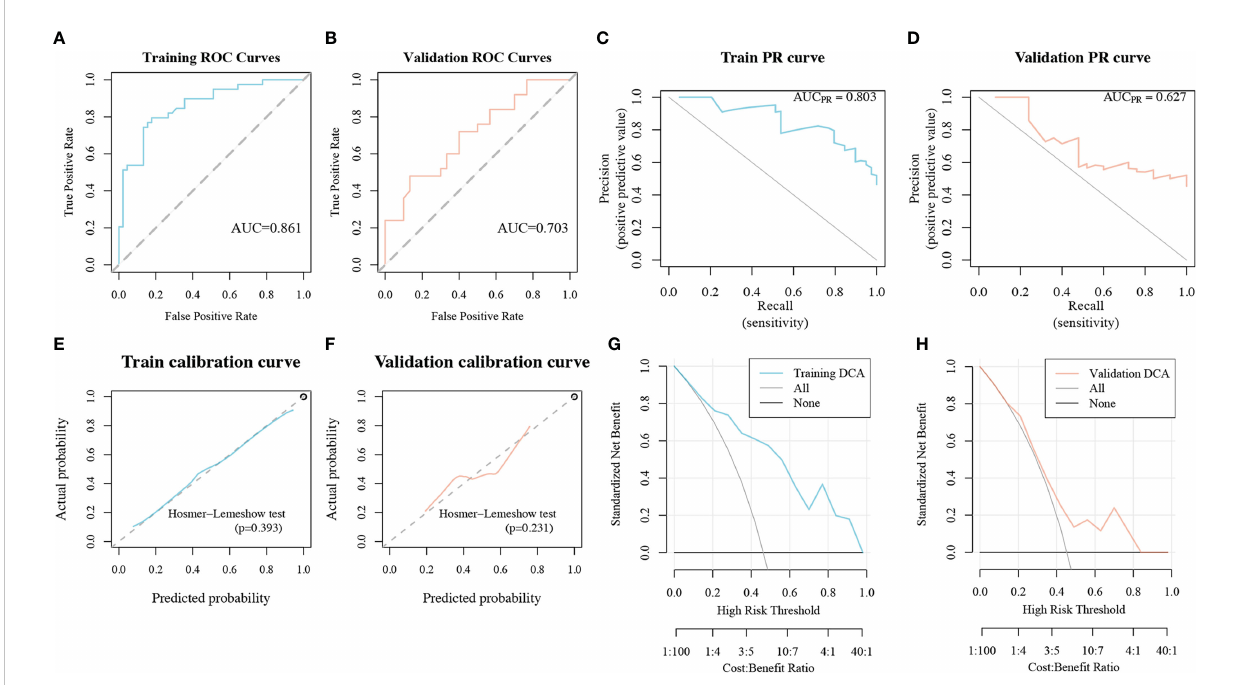
FIGURE 7 The performance of the radiomics model in the IL1B grading evaluation. (A, B) ROC curves of the radiomics model in training and validation cohorts. (C, D) PR curves of the radiomics model in training and validation cohorts. (E, F) Calibration curves of the radiomics model in training and validation cohorts. (G, H) DCA curves of the radiomics model in training and validation cohorts. ROC, Receiver operating characteristic; PR, precision recall; DCA, decision curve